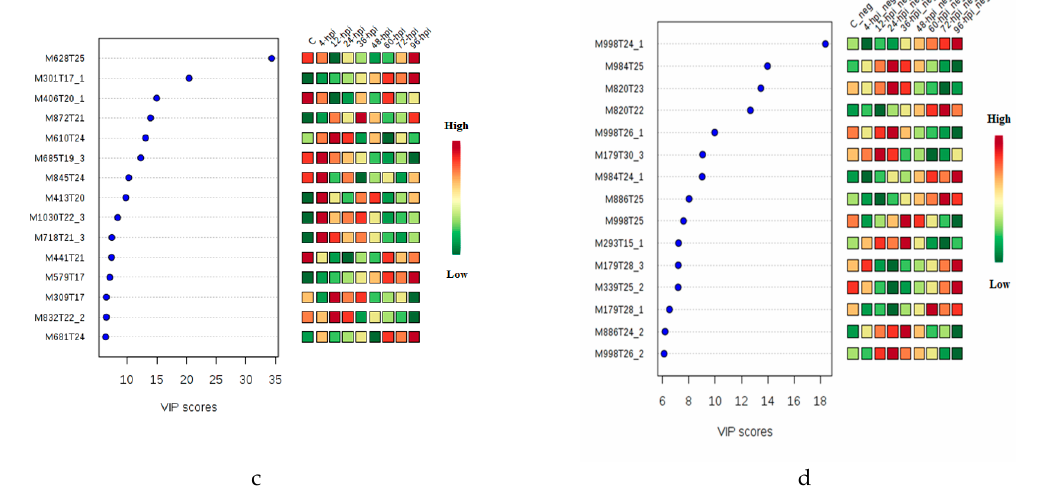
c d Figure 1. OPLS-DA score plots for the eight post-infection time points (4, 12, 24, 36, 48, 60, 72 and 96 hpi) and the initial control: ( a ) LC-ESI (+)-MS and ( b ) LC-ESI ( − )-MS. VIP score-plot derivate of PLS-